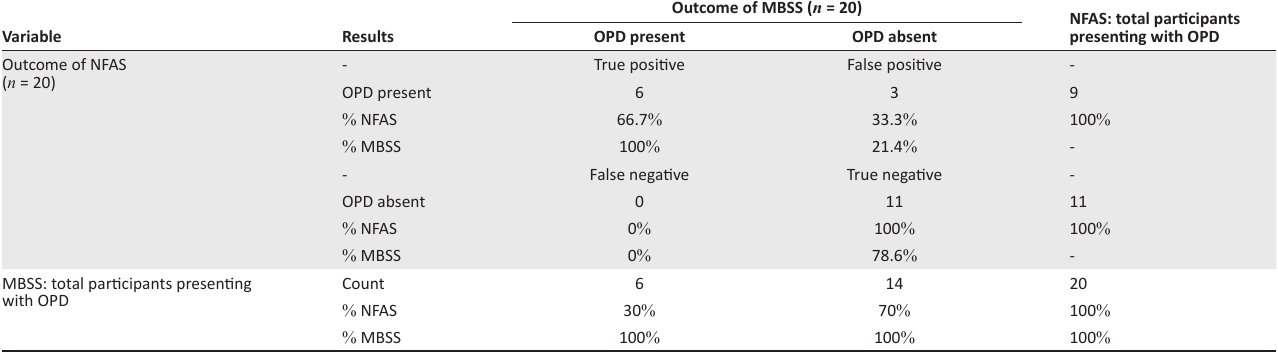
TABLE 4: Comparison between the MBSS and NFAS results ( n =